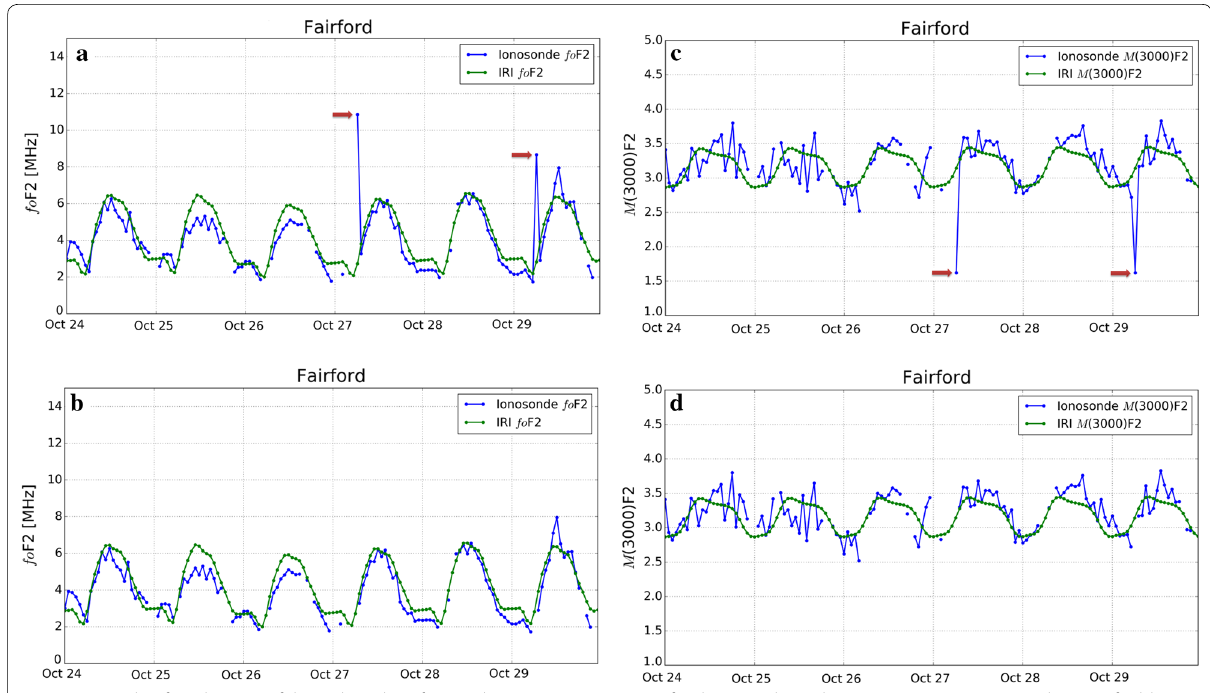
Fig. 2 Example of application of the F algorithm. fo F2 and M (3000)F2 time series for the period October 24–29, 2016 (storm number 30 of Table 3) before ( a , c , respectively) and after ( b , d , respectively), applying the F algorithm. Red arrows indicate spikes which are then discarded by the F